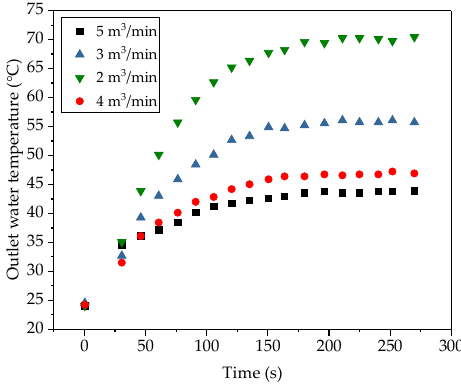
Figure 6. Outlet water temperature rise.